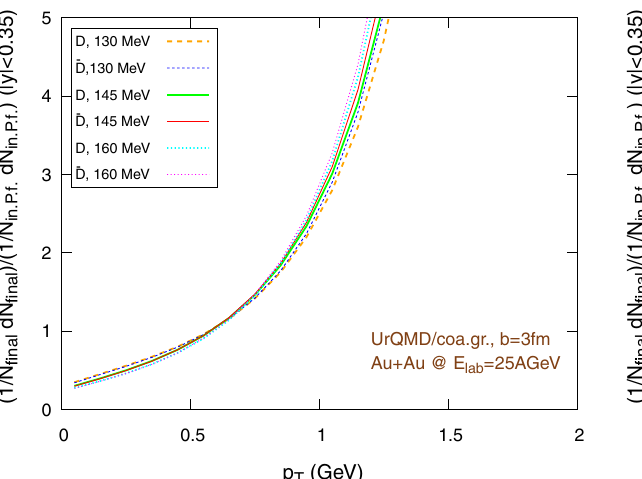
Fig. 17 ˜ R AA , i.e. the ratio of the individually normalized distributions 1 / N final d N final / d p T in Au+Au collisions and 1 / N in. Pyt. d N in. P. f. / d p T in pp collisions (Pythia + Peterson fragmentation), in the rapidity range